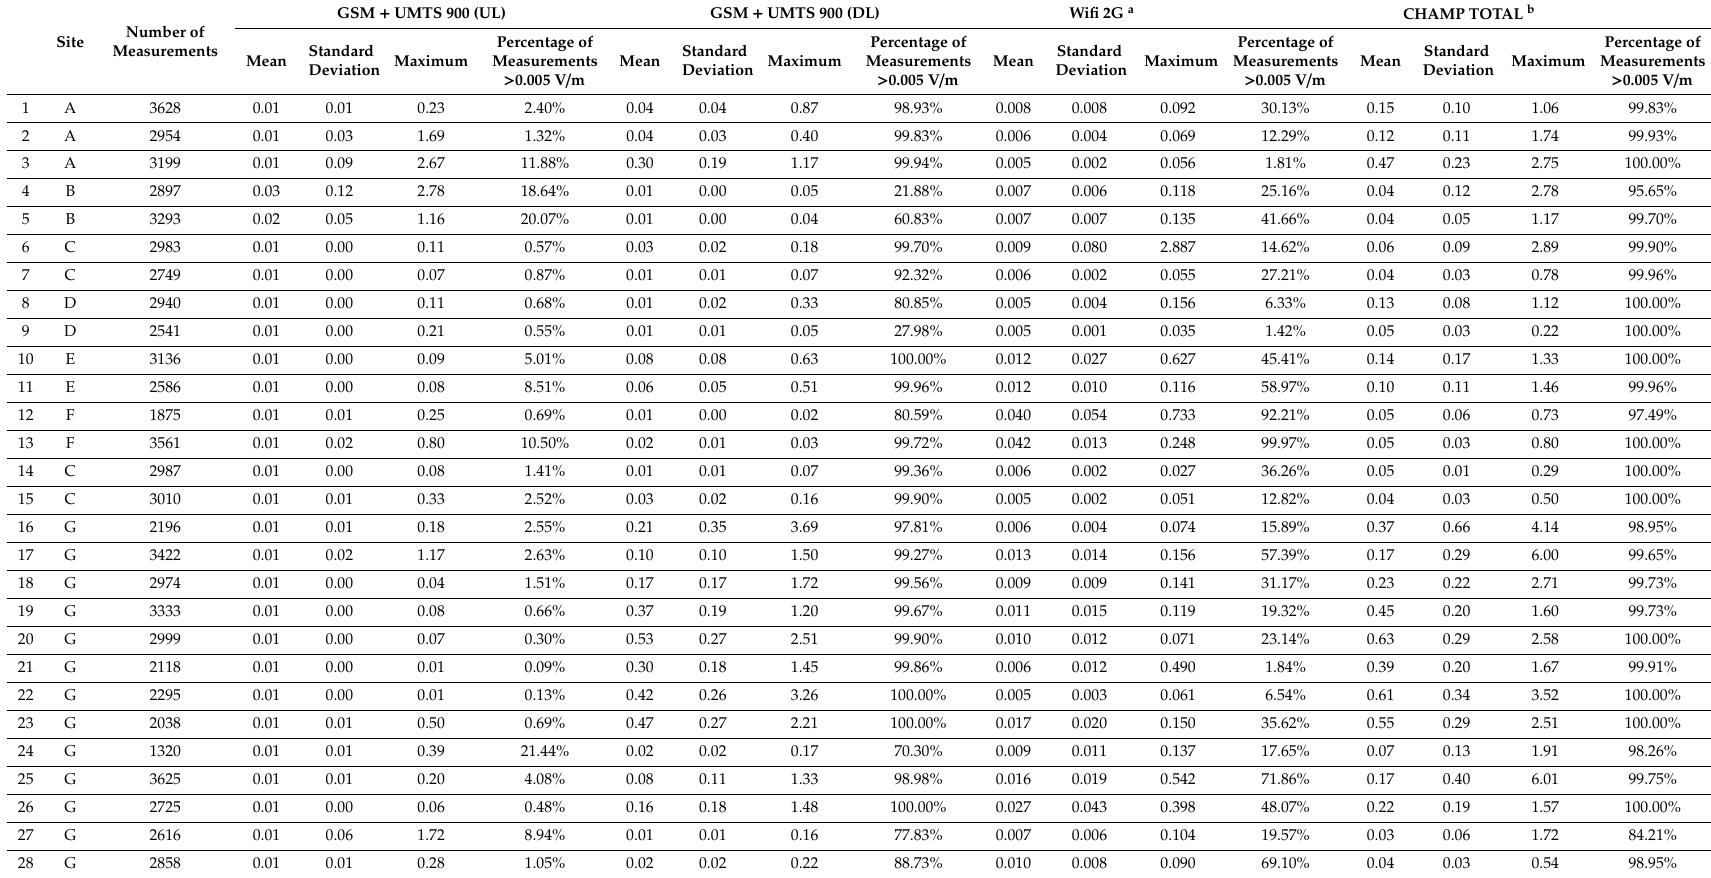
Table 3. Individual exposure samples for three frequency bands and total electromagnetic